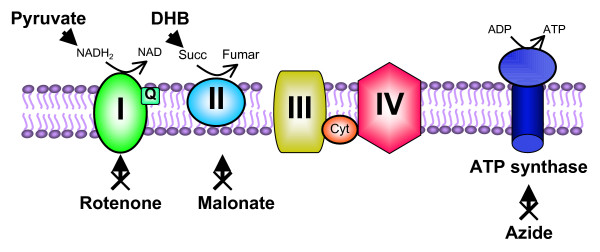
Scheme 1 : Mitochondrial enzyme complexes of the respiratory chain and inhibition sites.